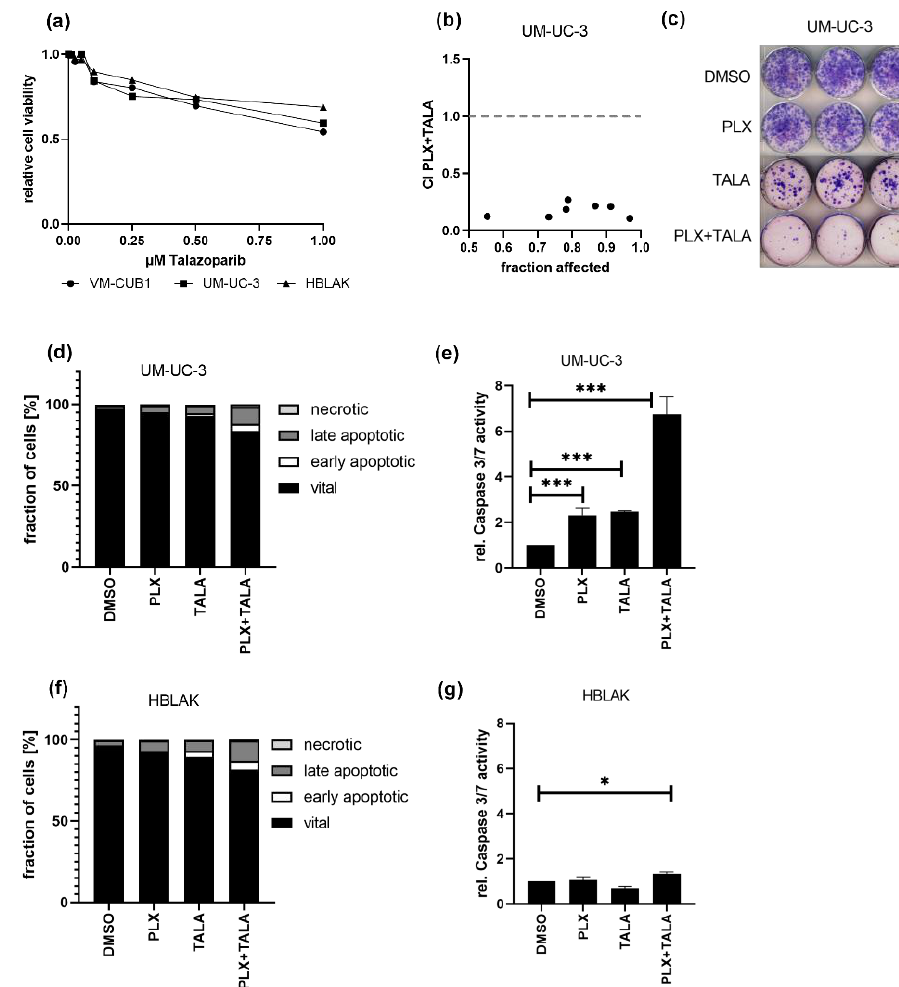
Figure 7. Strong synergistic action of combined treatment with PLX and PARPi talazoparib. ( a ) Cell viability 72 h after mono-treatment with indicated doses of talazoparib was measured by MTT assay. Relative cell viability normalized to respective DMSO controls is displayed. ( b ) CI plot for simultaneous treatment of UM-UC-3 with PLX and talazoparib (TALA) for 72 h. Applied combination dosages are given in Table S4. ( c ) Clonogenic growth following treatment with reduced drug concentrations (0.6 µM PLX, 0.5 µM TALA). ( d ) Induction of cell death was measured by annexin V/PI staining and flow cytometry 72 h after treatment with a reduced dosage. Percentage of viable, early apoptotic, late apoptotic, and necrotic cells is displayed in bar graphs in different shades of gray as indicated. ( e ) Activity of caspase 3 and 7 was measured in the same samples used for flow cytometry by luminometric caspase assay. In parallel, the samples were used for a luminometric ATP assay to normalize caspase activity to cell numbers (rel. caspase activity). Further normalization to respective DMSO controls (set as 1) was applied. *** denotes p < 0.001, * p < 0.05. Likewise, cell death induction was analyzed for HBLAK cells ( f , g ).